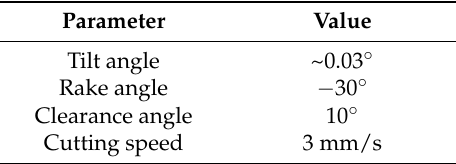
Table 4. Cutting parameters for the plunge cutting experiments.